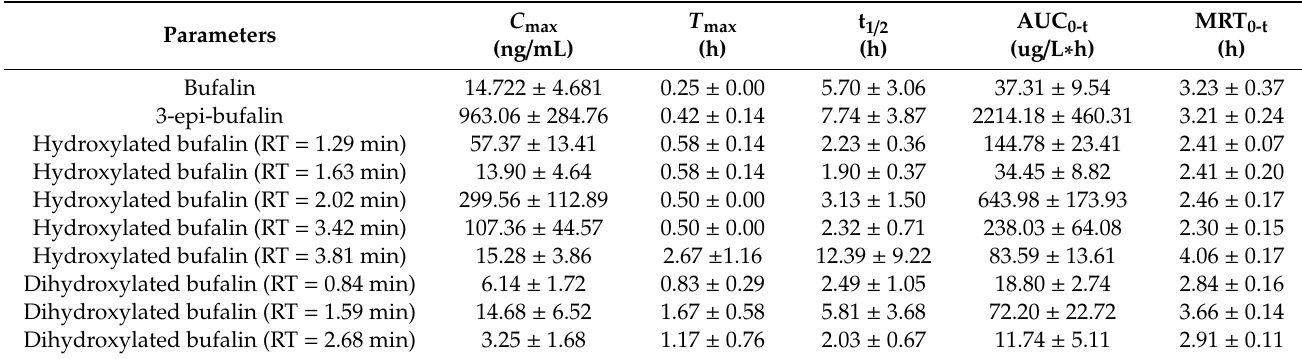
Table 6. Pharmacokinetics parameters of bufalin and its metabolites after a single oral administration of 10 mg / kg bufalin to rats ( n = 3, mean ±